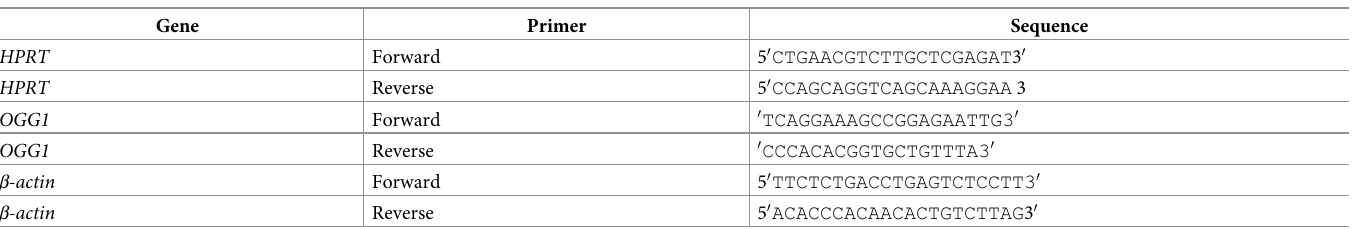
Table 4. Primer sequence of HPRT , OGG1 and β -actin gene.